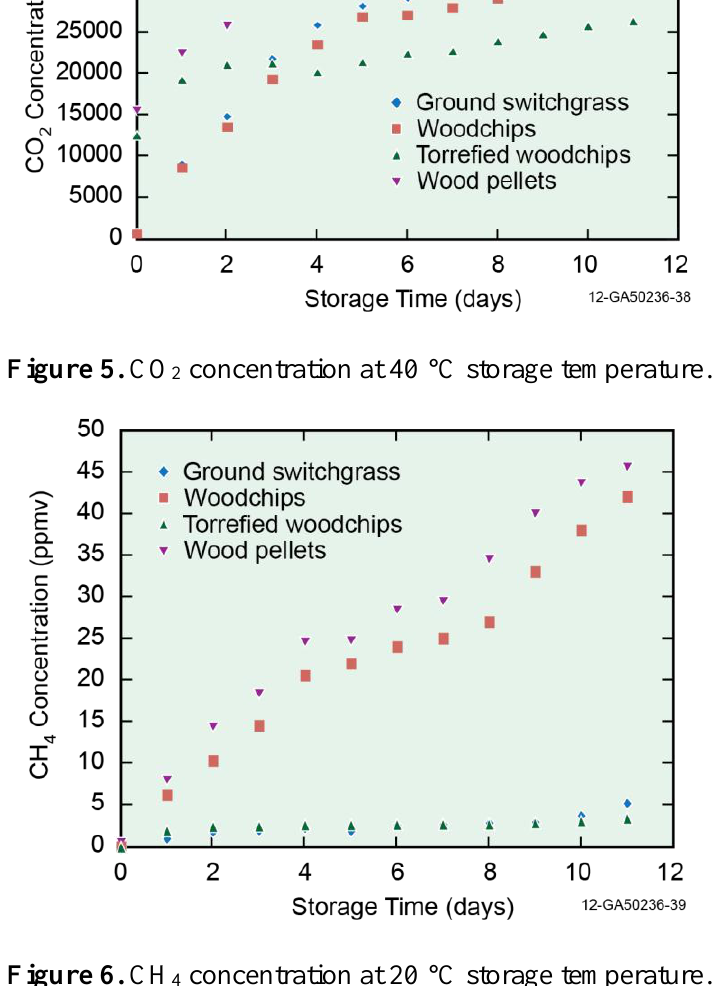
Figure 6. CH 4 concentration at 20 °C storage temperature.